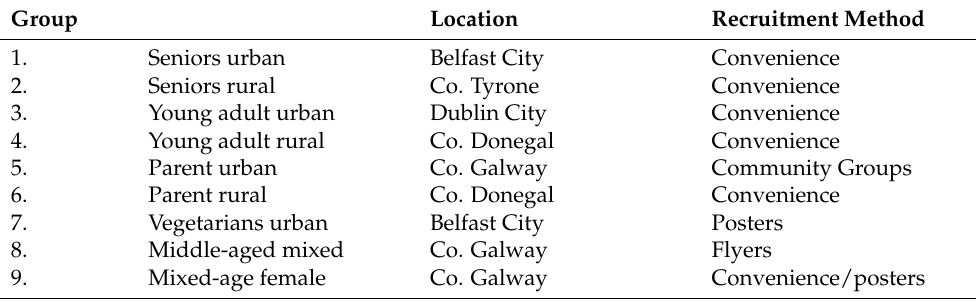
Table 1. Survey sample